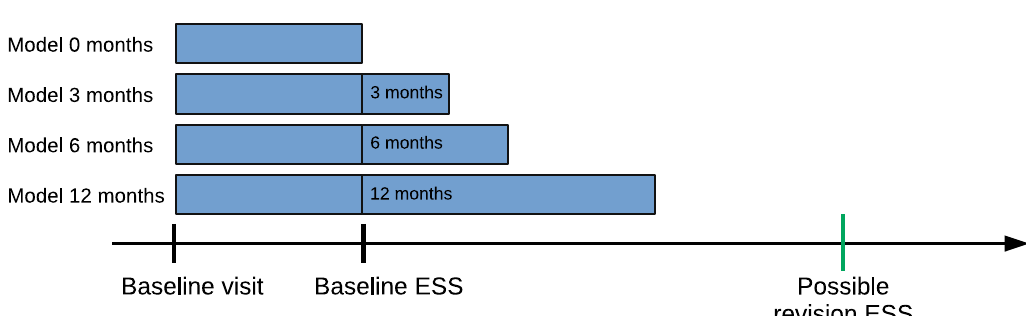
Fig 2. Data collection for the analysis of the effect of the data collection time period. The classifiers’ performance was calculated based on when the data were collected from the timeline of the baseline visit to the baseline ESS or to 3, 6 or 12 months following the baseline ESS. The baseline visit represents the initial clinic visit, and baseline ESS represents the first ESS identified in EHRs. Revision ESS represents the ESS performed following baseline ESS during the follow-up time period. The models were trained to predict the revision ESS. ESS, endoscopic sinus surgery; EHR, electronic health record.